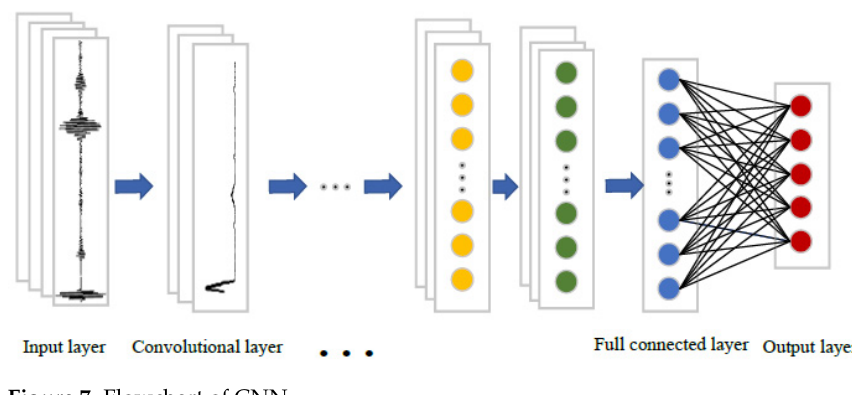
Figure 7. Flowchart of CNN.